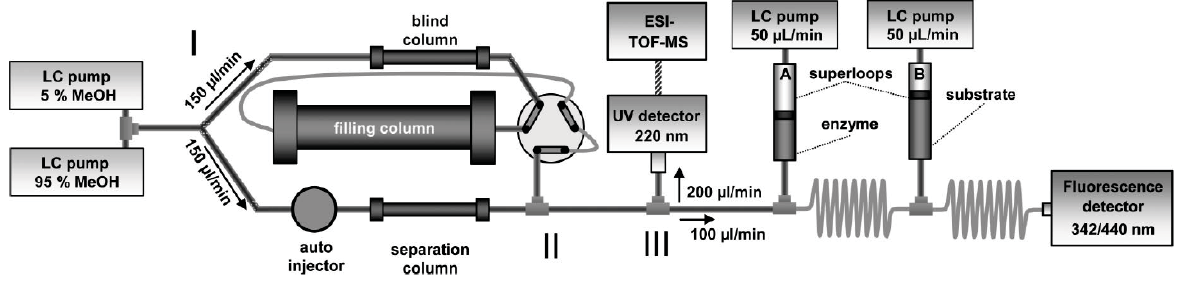
Figure 4. Biochemical detector with a countergradient parking system to reduce solvent inhibition effects [88]. Reprinted with permission from [88]. Copyright (2008) American Chemical